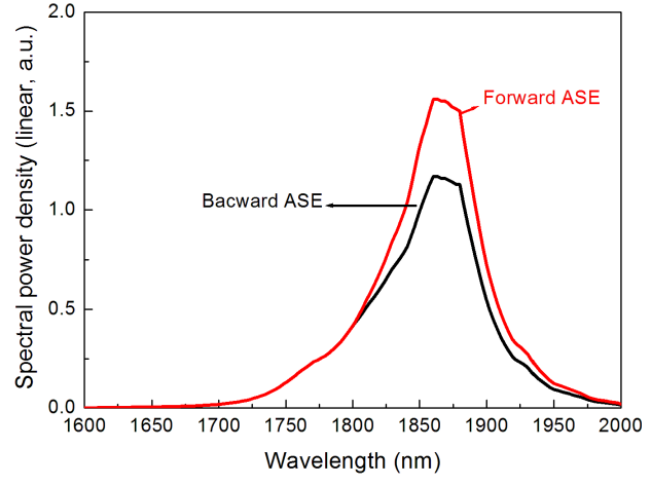
Figure 3. The forward and backward Amplified Spontaneous Emission (ASE) intensity spectra of a 5-cm 9/125 Tm 3+ -doped silicate fiber, core pumped by a 900-mW 1575-nm